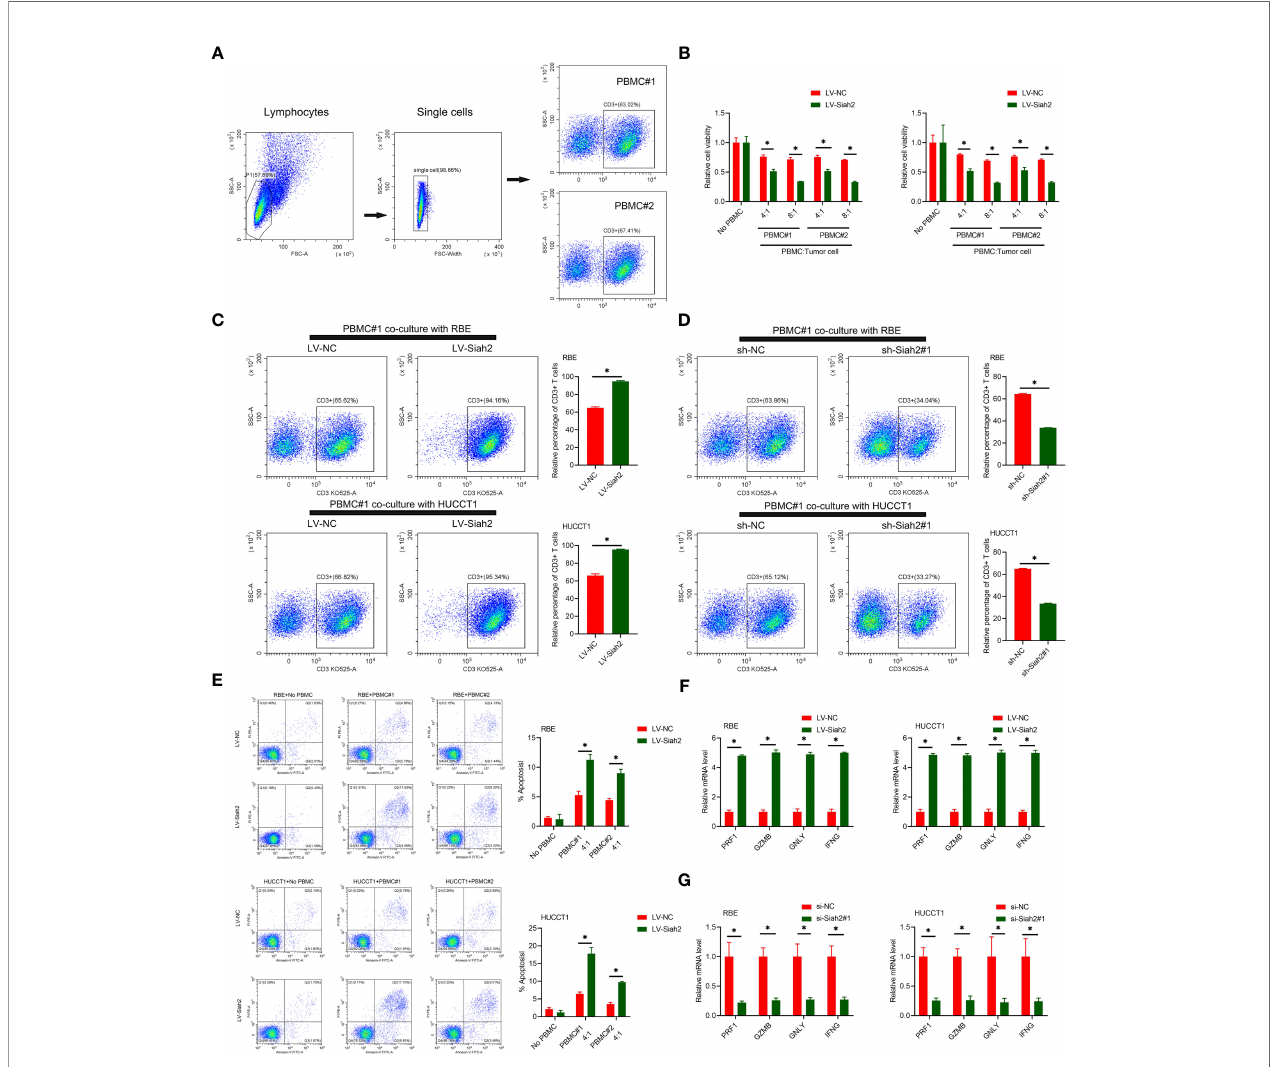
FIGURE 5 | Siah2 enhanced in vitro antitumor T-cell activity. (A) , Gating strategy and T cell percentage of activated PBMC. (B) , CCK8 assay detected the killing of tumor cells by activated HPBMC. CCA cells were co-cultured in the presence or absence of HPBMC for 24 h. Data were normalized to their respective no HPBMC controls. (C, D) , Activated HPBMC (#1, #2) were co-cultured with LV-NC/LV-Siah2 (C) or sh-NC/sh-Siah2 (D) for three days at the ratio of HPBMC to tumor cell number of 4 to 1. The percentage of CD3 in HPBMC was determined by FCM. Representative plots of CD3 + T cells are shown. Data were normalized to the control group. (E) , Activated HPBMC (#1, #2) were co-cultured with CCA with LV-NC/LV-Siah2 cells for 24 h at the ratio of HPBMC to tumor cell number of 4 to 1. HPBMC were collected and stained with PE-Annexin V and subjected to FCM analysis. The percentage of apoptotic cells was analyzed. (F, G) , Quantitative RT-PCR was performed to detect PRF1 (perforin-1), GZMB (granzyme), GNLY (granulysin), and IFNG (IFN- g ) in activated HPBMC co-cultured with CCA cells with LV-NC/LV-Siah2 (G) for the indicated time or with si-NC/si-Siah2 cells for 48 h. The ratio of HPBMC to tumor cell number was 4 to 1. Mean±SEM of three independent experiments.